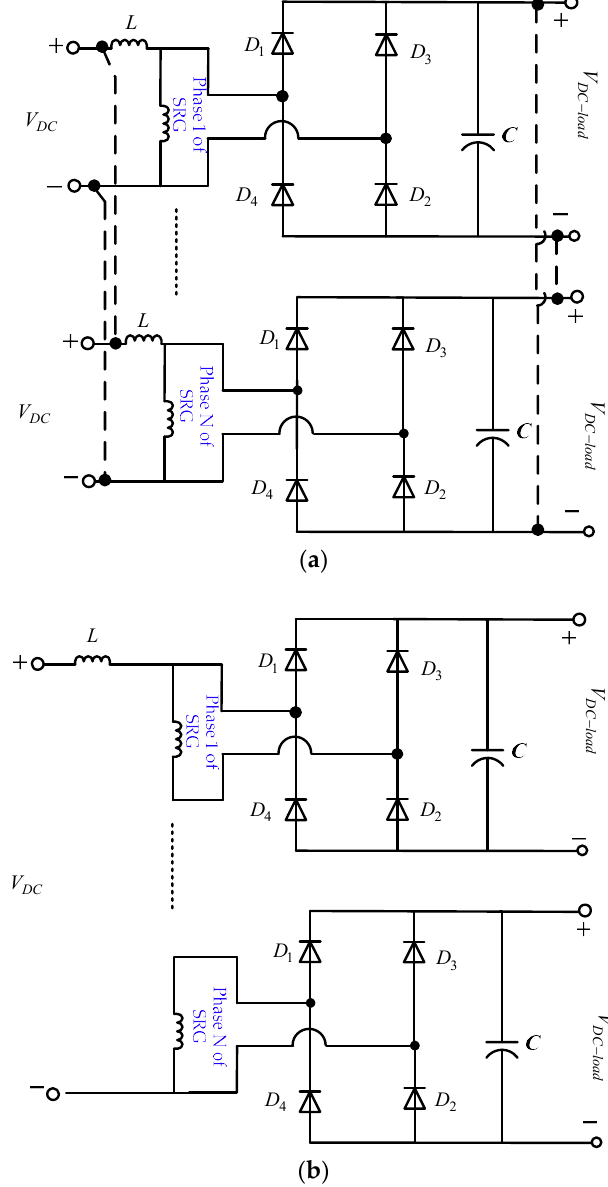
Figure 10. Vujicic–Calasan SRG power converters. ( a ) First power converter topologie (PTC1). ( b ) Secand power converter topologie (PTC2). ( b ) Second power converter topologie